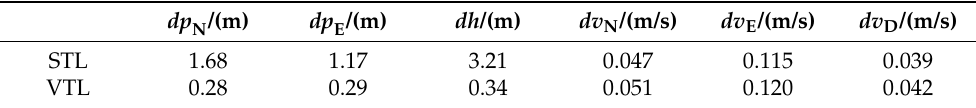
Figure 11. Comparison of navigation errors between STL and VTL in case of constant signal power. ( a ) Position error; ( b ) velocity error. Table 4. Navigation root-mean-square errors statistics table.